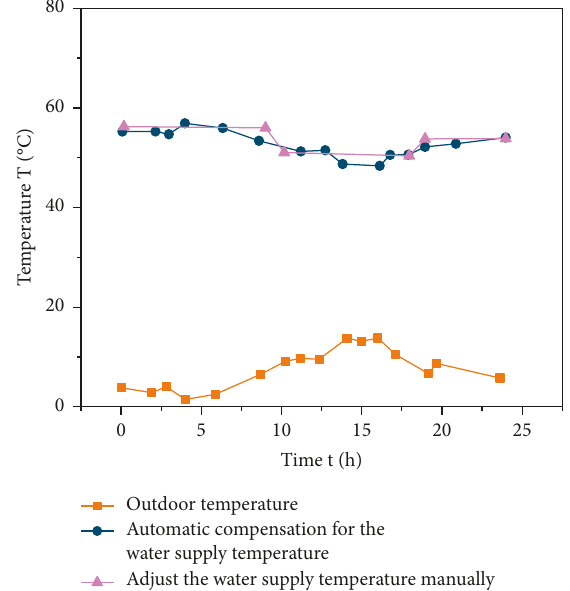
Figure 6: 24-hour operation data of heat exchange